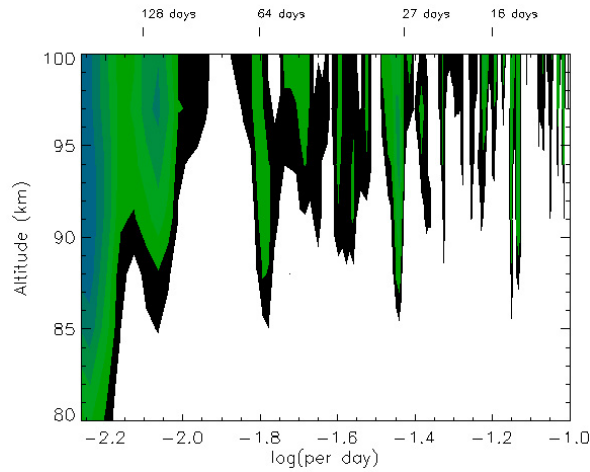
Fig. 4. As Fig. 3, but for a “middle” range of frequencies.